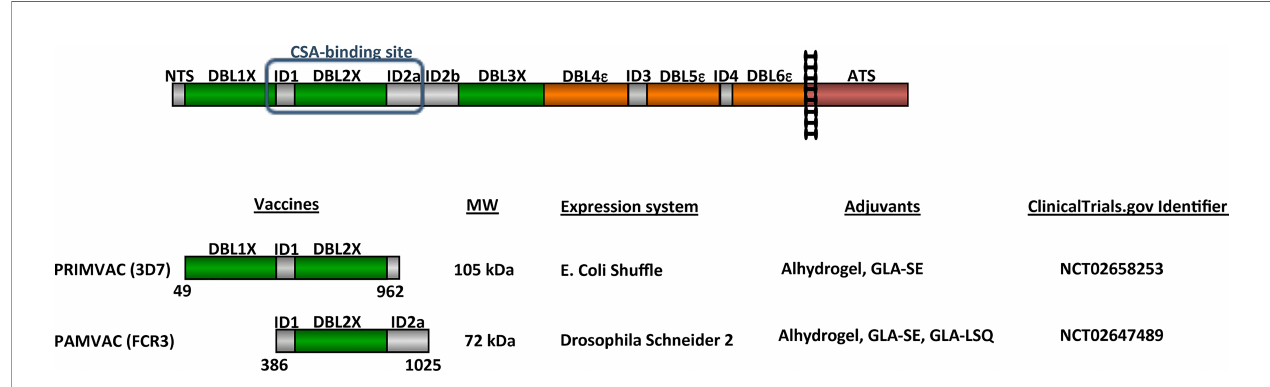
FIGURE 1 | Schematic representation of VAR2CSA and vaccines tested in clinical trials. VAR2CSA is a 350-kDa transmembrane protein composed of an N-terminal segment (NTS) followed by six Duffy-binding like (DBL) domains interspaced by 4 inter-domains (ID), a transmembrane region and a cytoplasmic Acidic C terminus sequence (ATS). PRIMVAC and PAMVAC schematic representation with sequences boundaries, predicted molecular weight, expression systems, and adjuvants used for the Phase I clinical trials. ClinicalTrials identi fi er for both Phase I